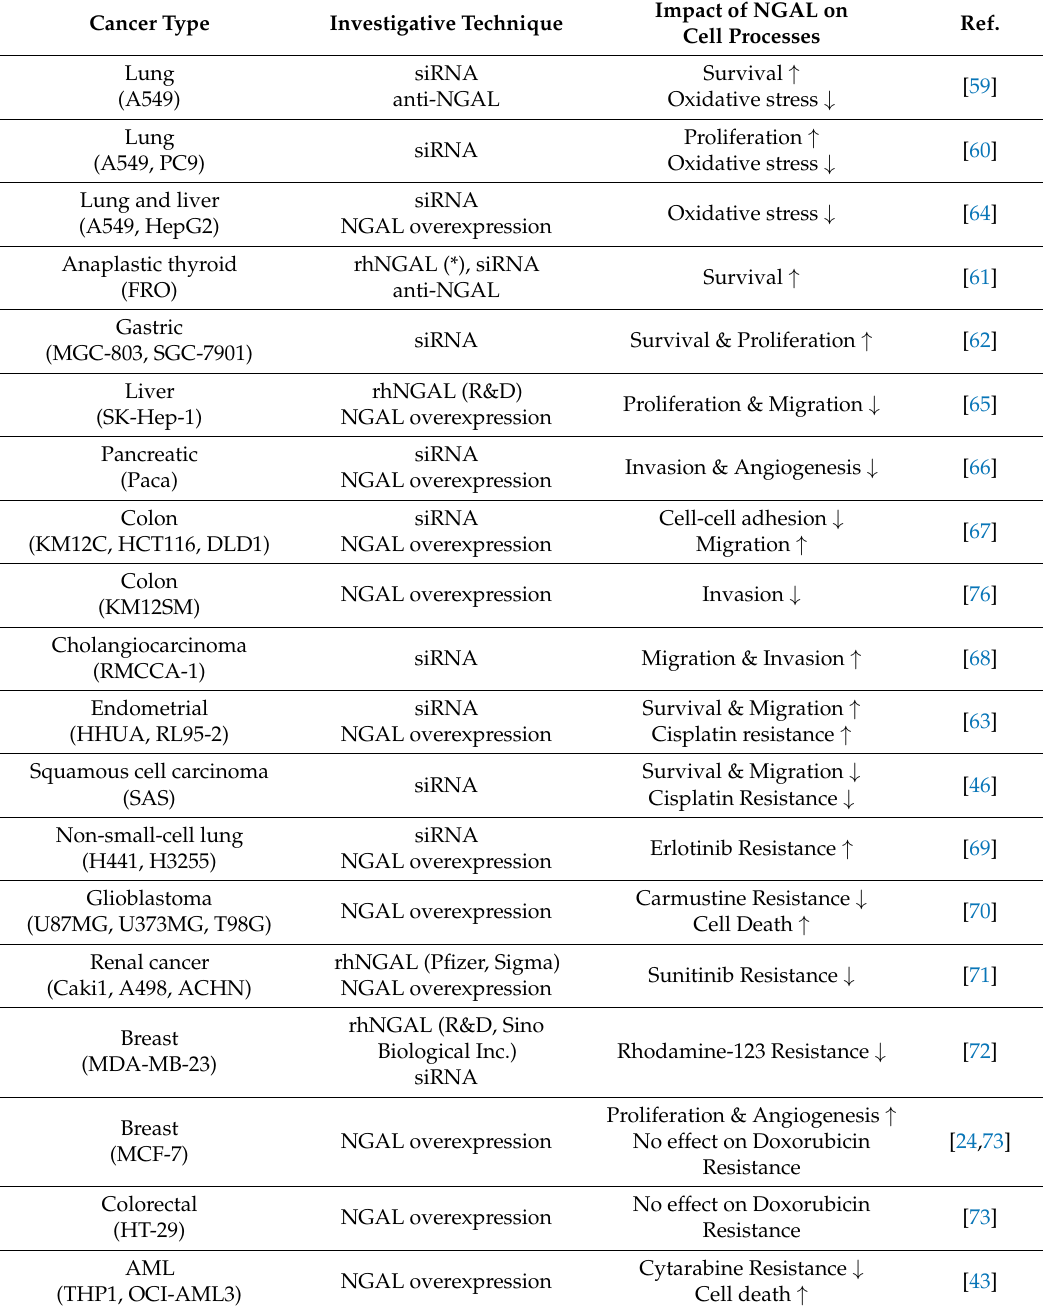
Table 2. Beneficial and detrimental effects of neutrophil gelatinase-associated lipocalin (NGAL) in